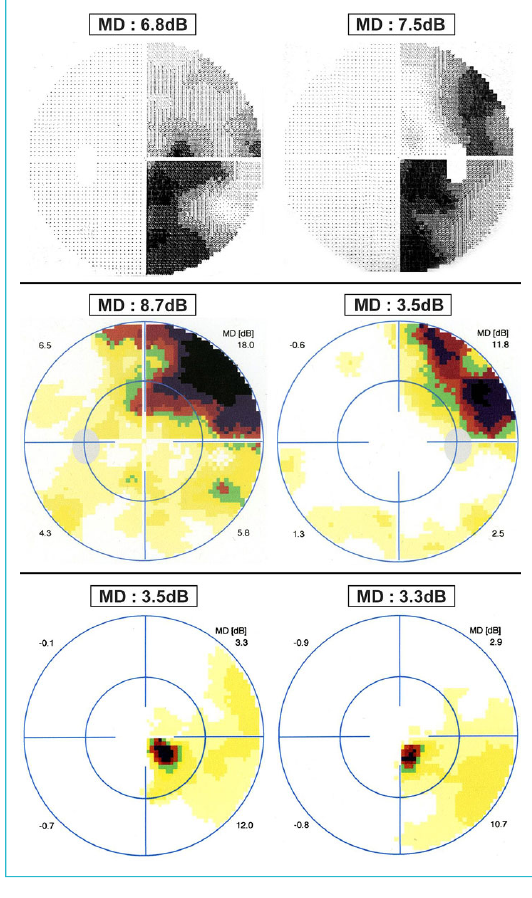
Figure 2: Examples of homonymous visual field defects in patients with multiple sclerosis. Top – right partial homonymous hemianop- sia (30° visual field, program G1). Middle – partial right homony- mous quadrantanopsia (30° visual field, program G1). Bottom –